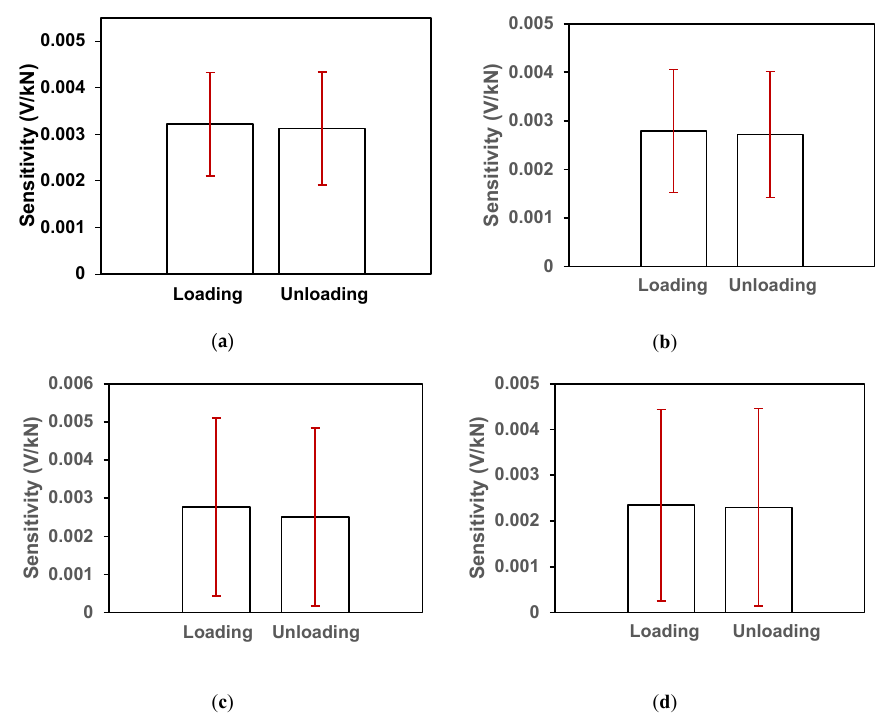
Figure 6. Average loading and unloading sensitivities in sample blocks impregnated with 0.1% CCNTs ( a ), 0.2% CCNTs ( b ), 0.3% CCNTs ( c ) and 0.5% CCNTs ( d ). The vertical error bars represent the standard deviations.